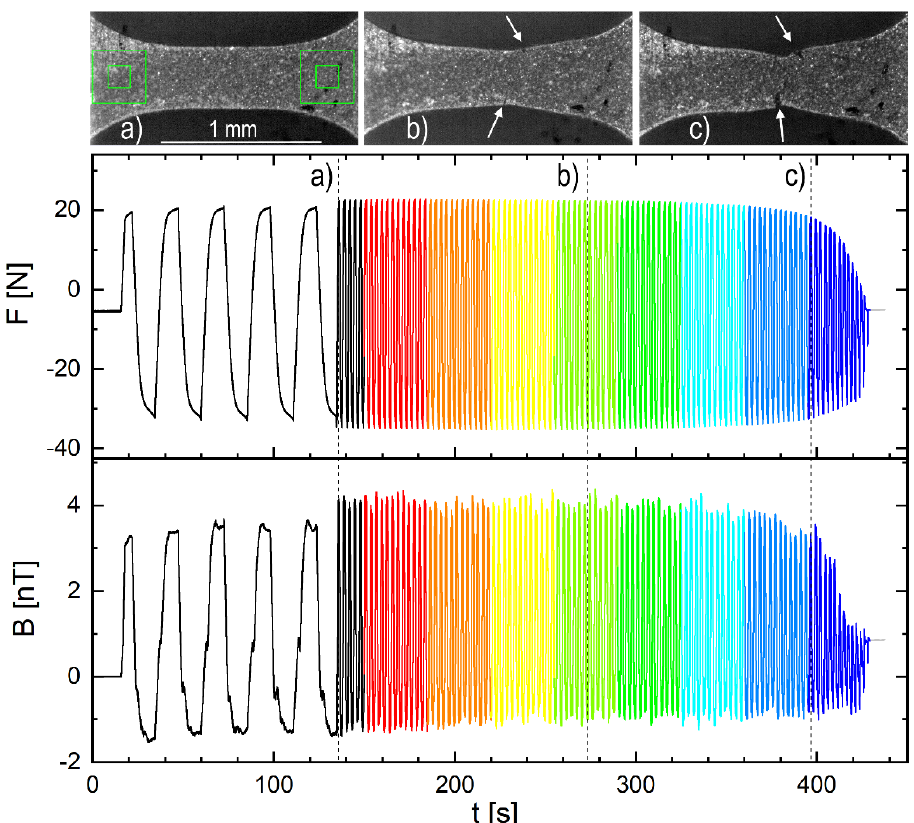
Figure 2. Piezomagnetic signals of a low-cycle fatigue (LCF) experiment using a small specimen made of ferritic steel (length 1.5 mm). The experiment used a uniaxial strain amplitude of ± 1.5 percent and 108 cycles over approximately 430 s. The force F and magnetic field B are displayed together with the corresponding DIC images of the SUT on the top (color coded). The green squares in ( a ) mark the search areas for the DIC. The arrows on the images ( b , c ) mark the locations of the crack formation. The macroscopic crack initiation is evaluated visually with the features in ( c ). After that point, the force signal decreases rapidly. The SUT breaks at the very end of the time